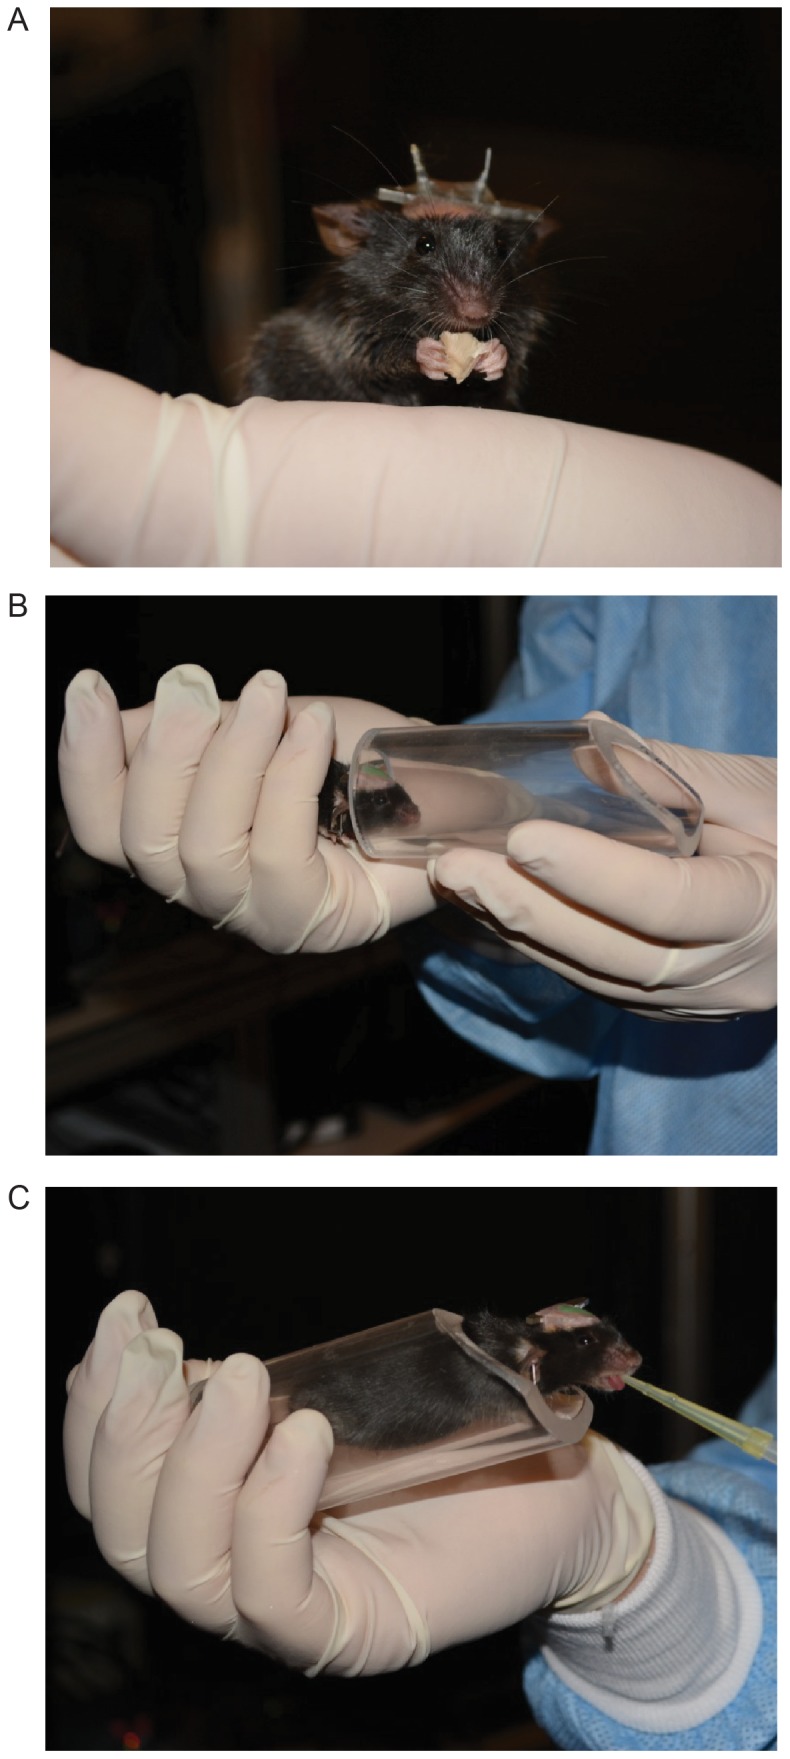
Key stages in mouse handling.A. Mouse eating a sunflower seed on the experimenter's hand. The pins emanating from the top of the mouse head correspond to ground and reference electrodes for extracellular recordings. B. Mouse being familiarized with the body tube. C. Mouse receiving a water reward in the body tube.